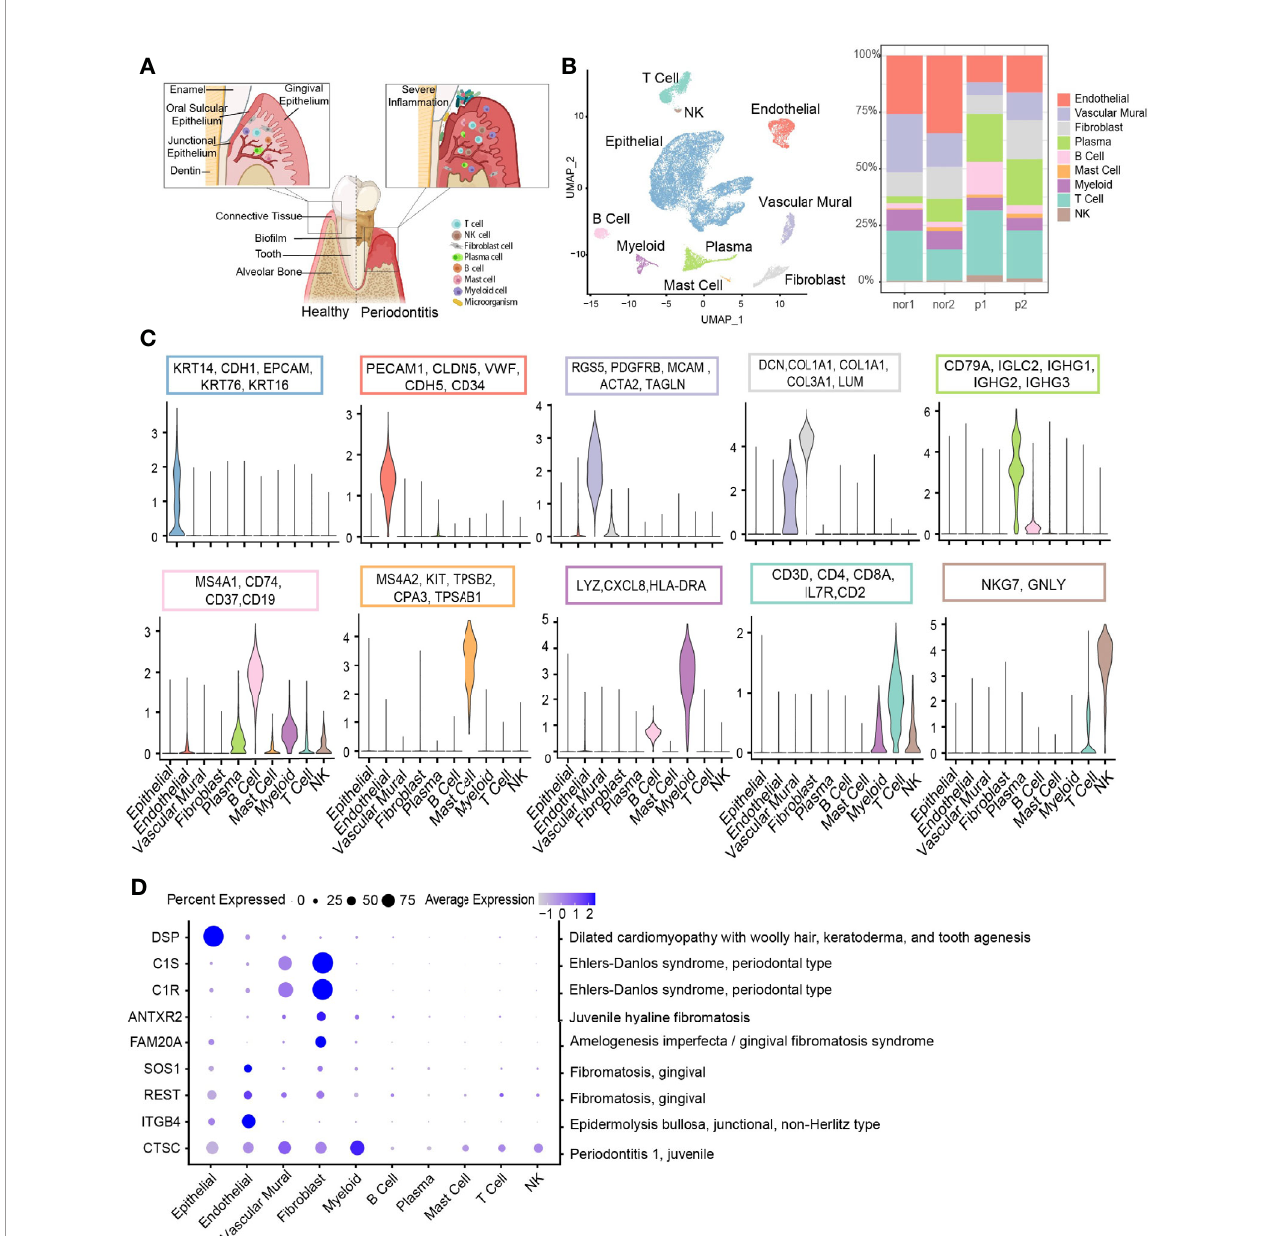
FIGURE 1 | Overview of the clustering and annotation of the single-cell RNA sequencing data for gingival tissues. (A) Schematic of gingival tissues in health (left) and periodontitis (right) analyzed in this study (The graph was created with BioRender.com). (B) UMAP representation of major cell types identi fi ed by scRNA-seq ( n = 4; 29,967 cells; left) and bar plots indicating the percentage of the nonepithelial of subtypes in each donor (Nor1 and Nor2 are healthy donors; P1 and P2 are periodontitis patients; right). (C) Violin plots showing the expression scores of selected canonical marker gene sets across all 10 subsets. (D) Dot plot depicting gene expression levels and percentage of cells expressing genes associated with periodontal disease according to the OMIM